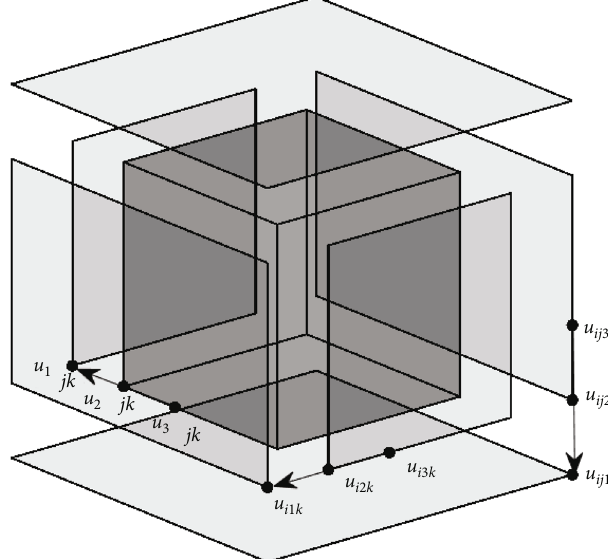
Figure 2: Schematic illustration of the linear boundary